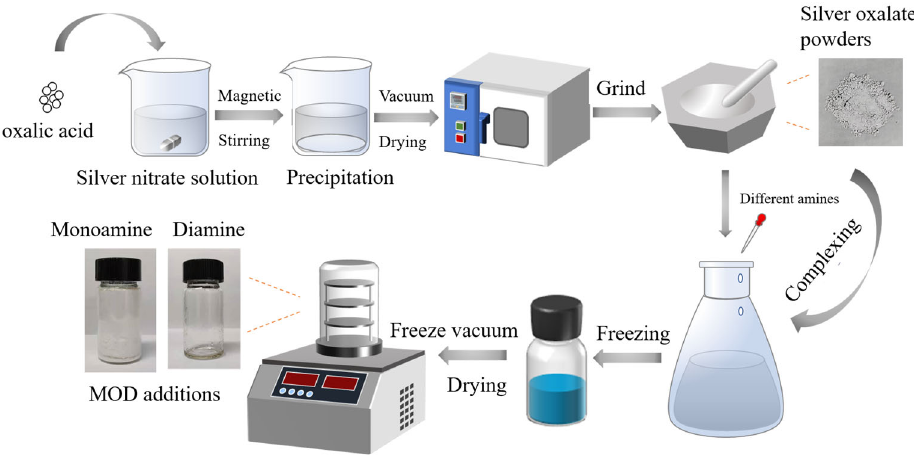
Figure 1. Schematic illustration of MOD preparations.